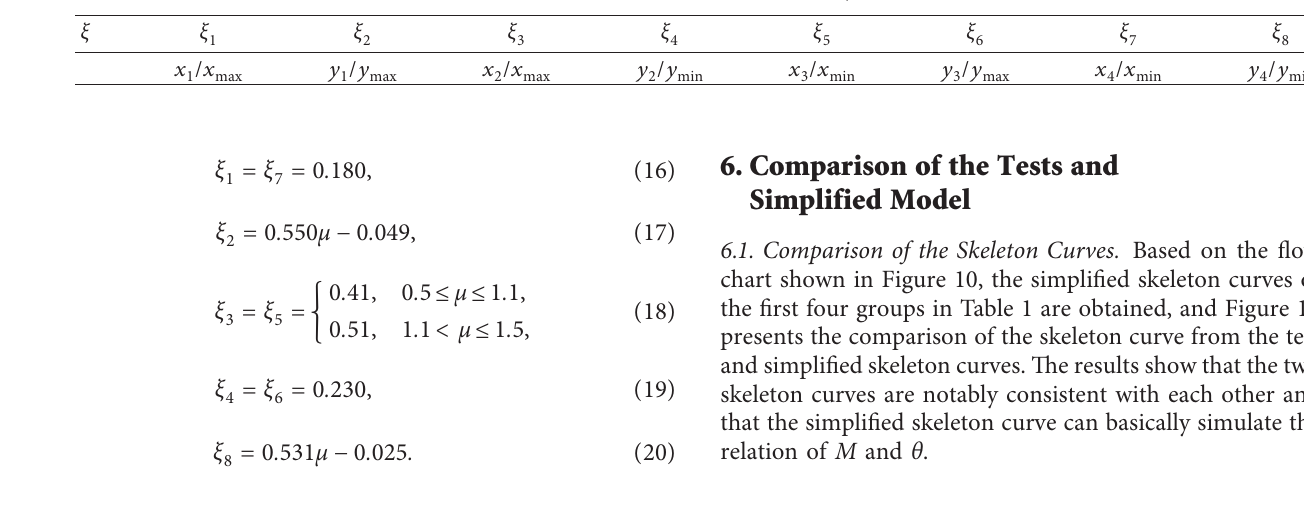
Figure 16: Comparison of the (a) hysteretic curve and (b) generation-absolute error curve between the test and the simplified model. Table 10: Detail information of ξ